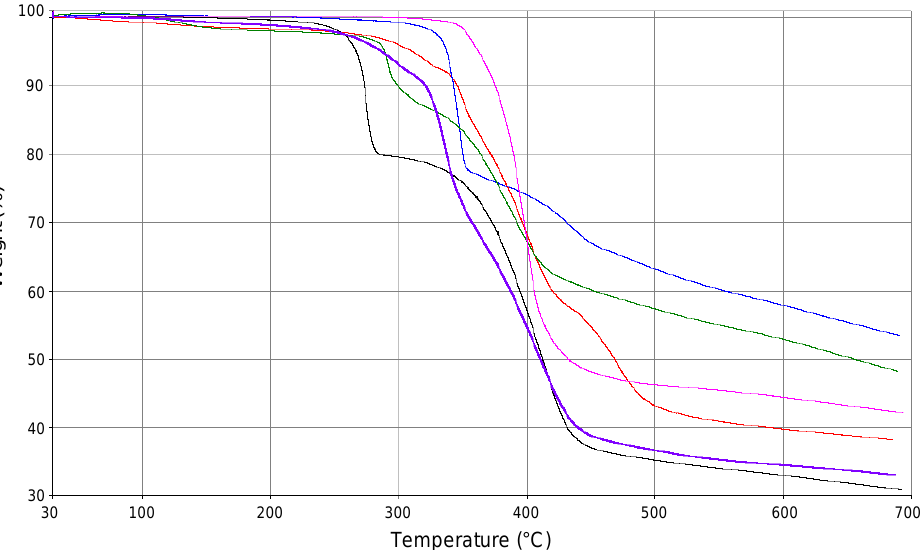
Figure 10. Thermogravimetric analysis (TGA) curves of silver(I) CPs 1 (green), 2 (black), 3 (fuchsia), 4 (red), 5 (blue), and 6 (purple).